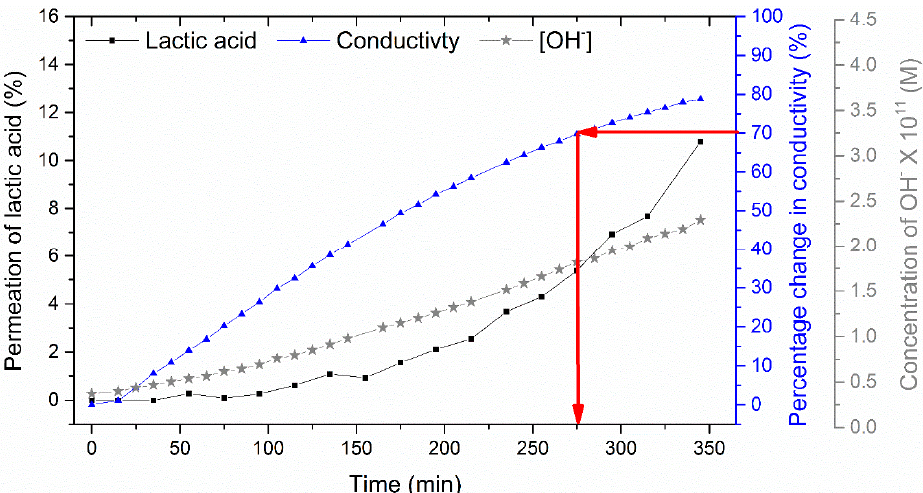
Figure 11. Effect of NaCl addition on lactic acid permeation at a constant voltage of 2.4 V. The red arrows indicate the point corresponding to 70% demineralisation, as measured by the diluate conductivity.